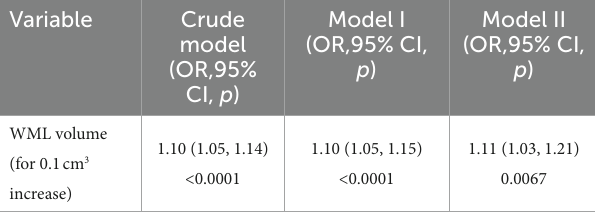
TABLE 4 Relationship between white matter lesions volume and bipolar disorder risk in different models.